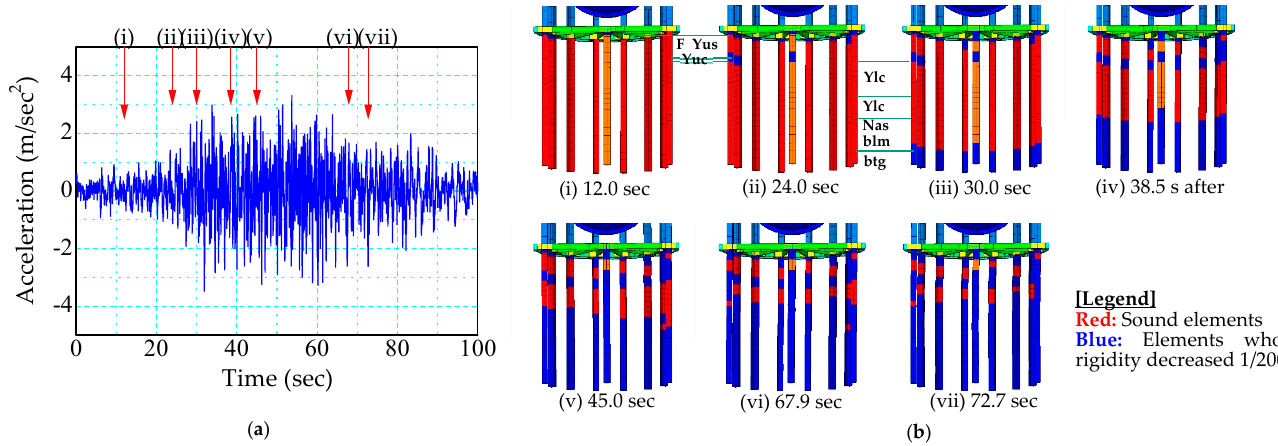
Figure 17. Status of pile damage progress: seismic motion (A): ( a ) input seismic motion and damage time; ( b ) pile damage.